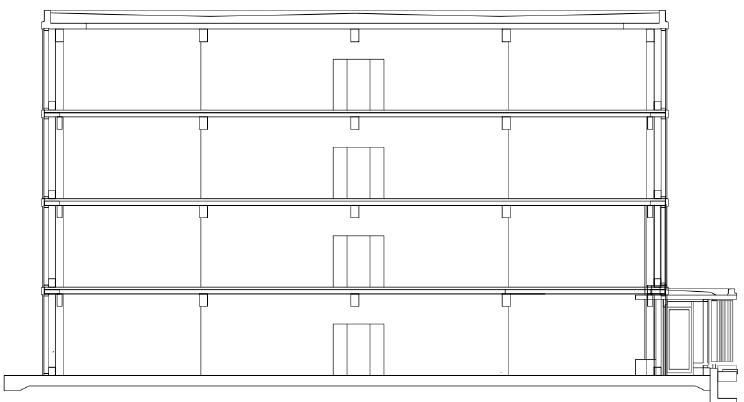
Figure 4. Longitudinal cross section of building B.